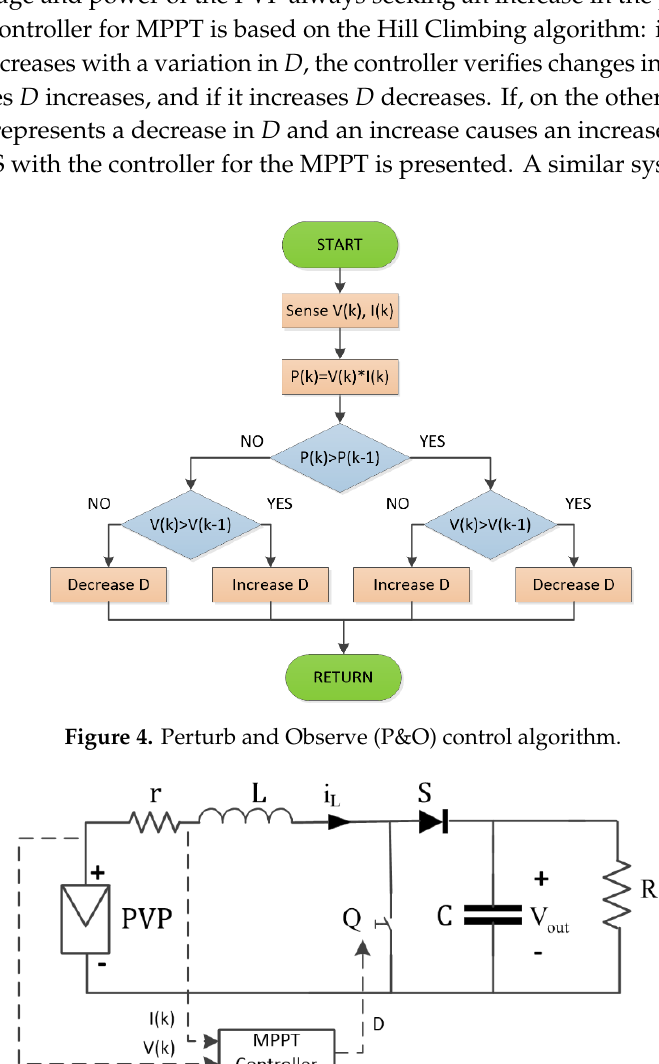
Figure 6. DC-DC PEC with a proportional integral (PI) controller. 𝑢(𝑡) = 𝑘 𝑝 𝑒(𝑡) + 𝑘 𝑖 ∫ 𝑒(𝜏)𝑑𝜏 𝑡 0